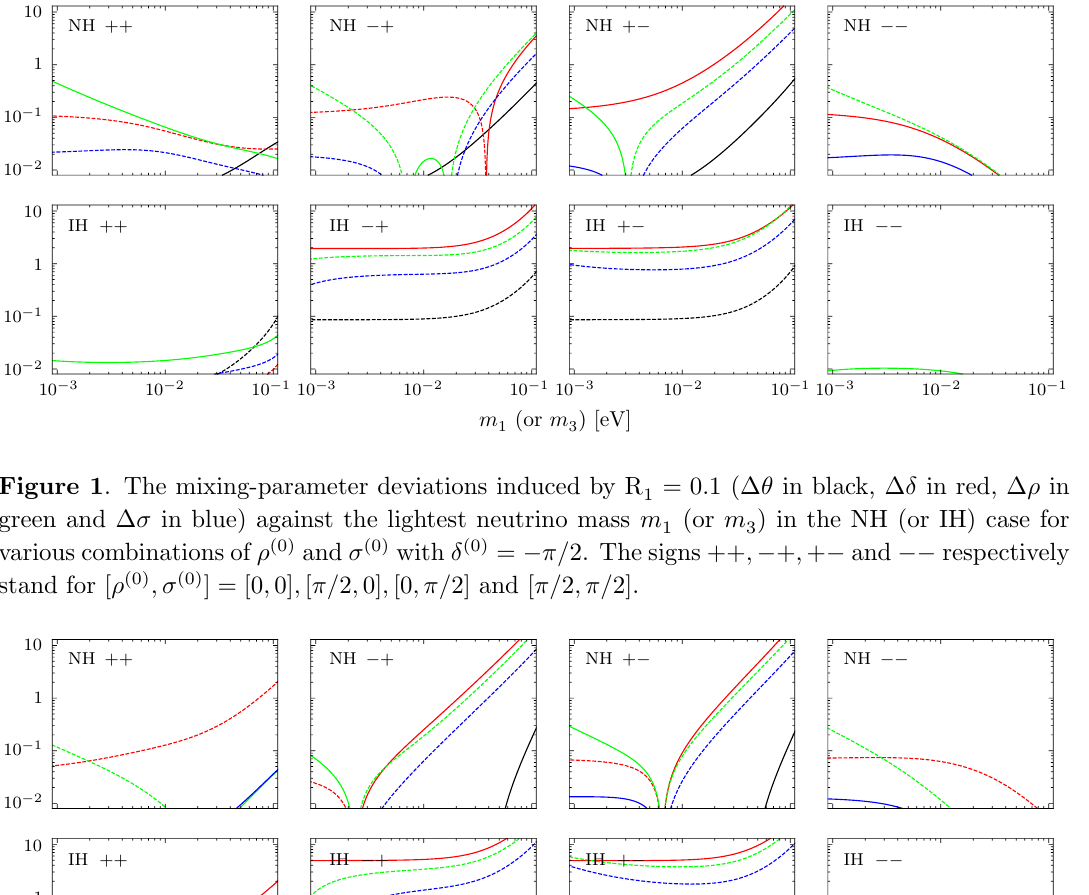
Figure 2 . The mixing-parameter deviations induced by I green and (cid:1) (cid:27) in blue) against the lightest neutrino mass m various combinations of (cid:26) (0) and (cid:27) (0) with (cid:14) (0) = (cid:0) (cid:25)= 2. The signs ++ ; (cid:0) + ; + (cid:0) and (cid:0)(cid:0) respectively stand for [ (cid:26) (0) ; (cid:27) (0) ] = [0 ; 0] ; [ (cid:25)= 2 ; 0] ; [0 ; (cid:25)= 2] and [ (cid:25)= 2 ; (cid:25)=